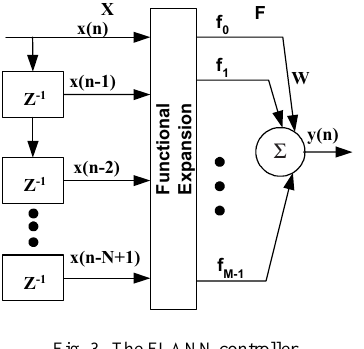
Fig. 3. The FLANN